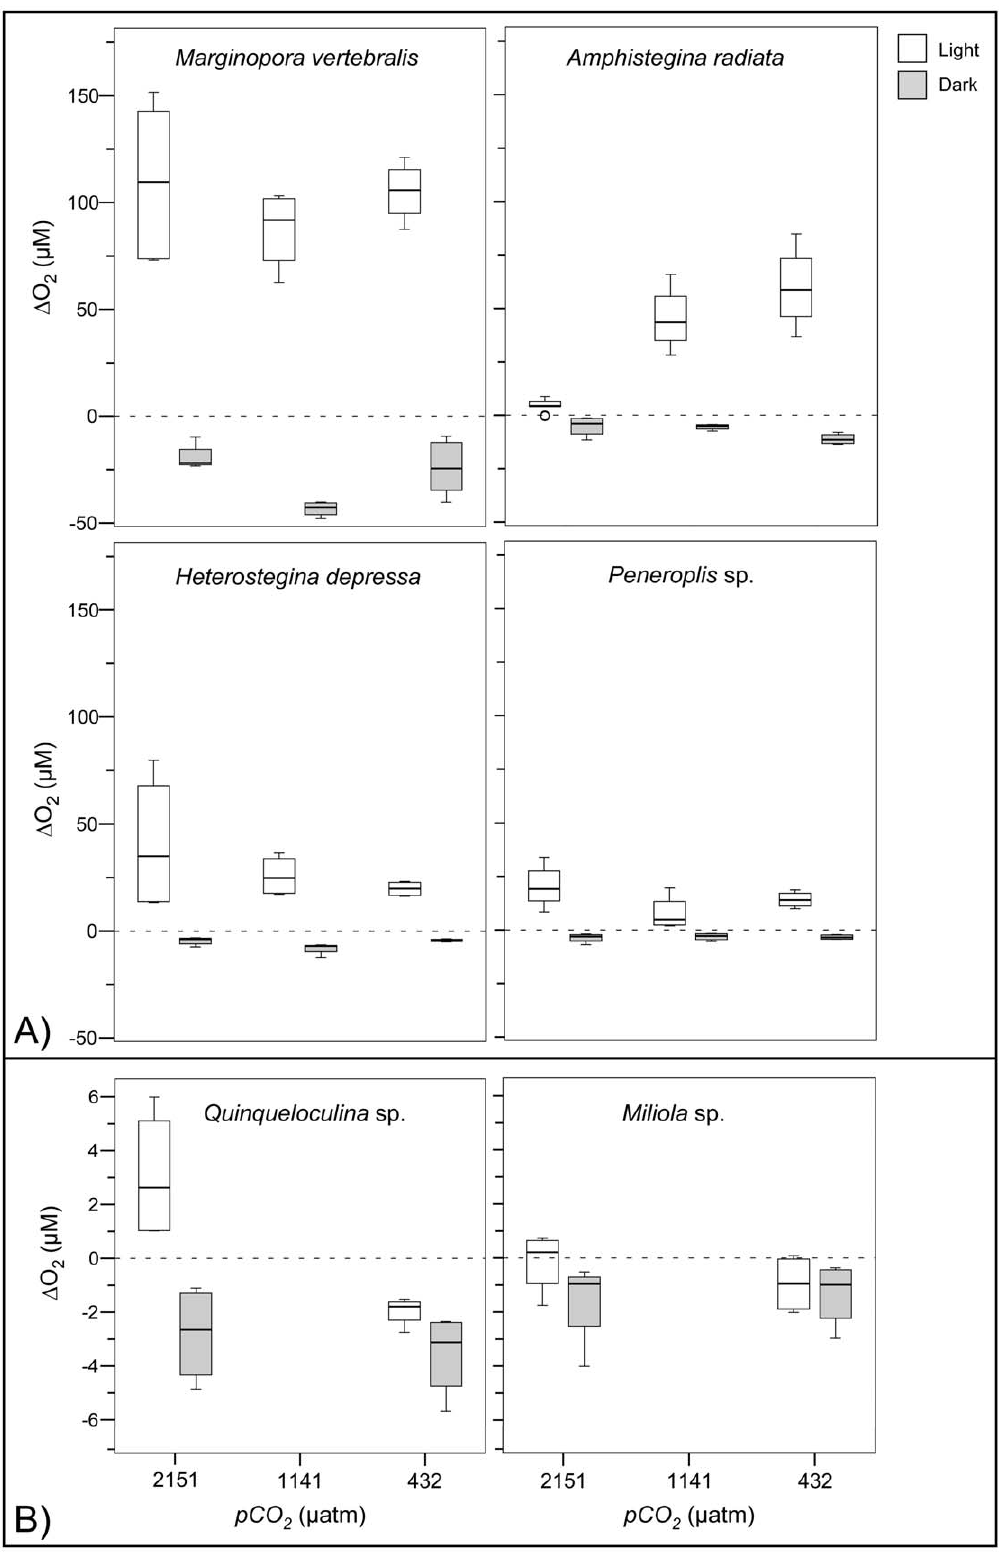
Figure 5. Box-plots representing the 25 th , 50 th and 75 th percentiles of D O 2 , calculated from profiles measured during the pCO 2 treatment incubations, at light (30 m mol photons m 2 2 s 2 1 ) and dark conditions for the six foraminiferal species. Note the different scales between A) photosymbiotic and B) symbiont-free species. Outliers ( . 1.5 interquartile range) are indicated by circles.